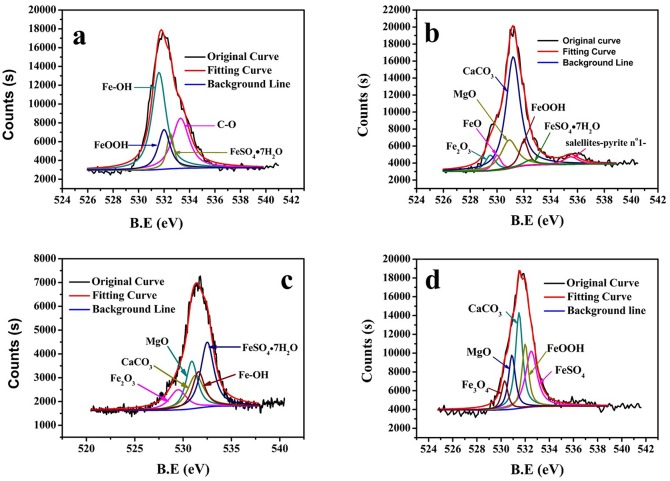
High-resolution S spectra of the corrosion product on the steel surface at various cathodic polarization potentials in SRB medium.a) OCP; b) -0.85VSCE; c) -0.95VSCE; d) -1.05VSCE.